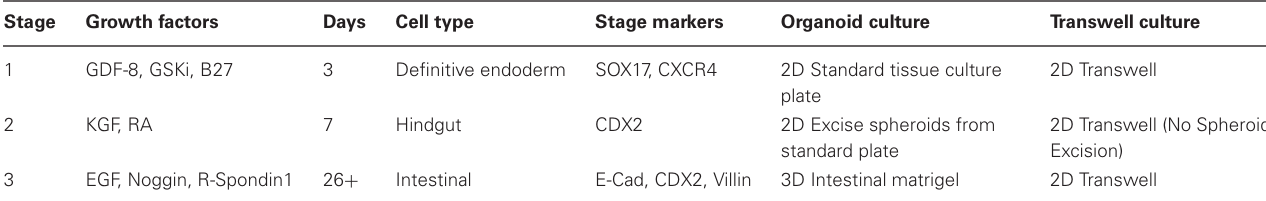
Table 1 | Summary of growth factors and differentiation cell culture conditions used for transwell differentiation, relative to previously established intestinal organogenesis to 3D